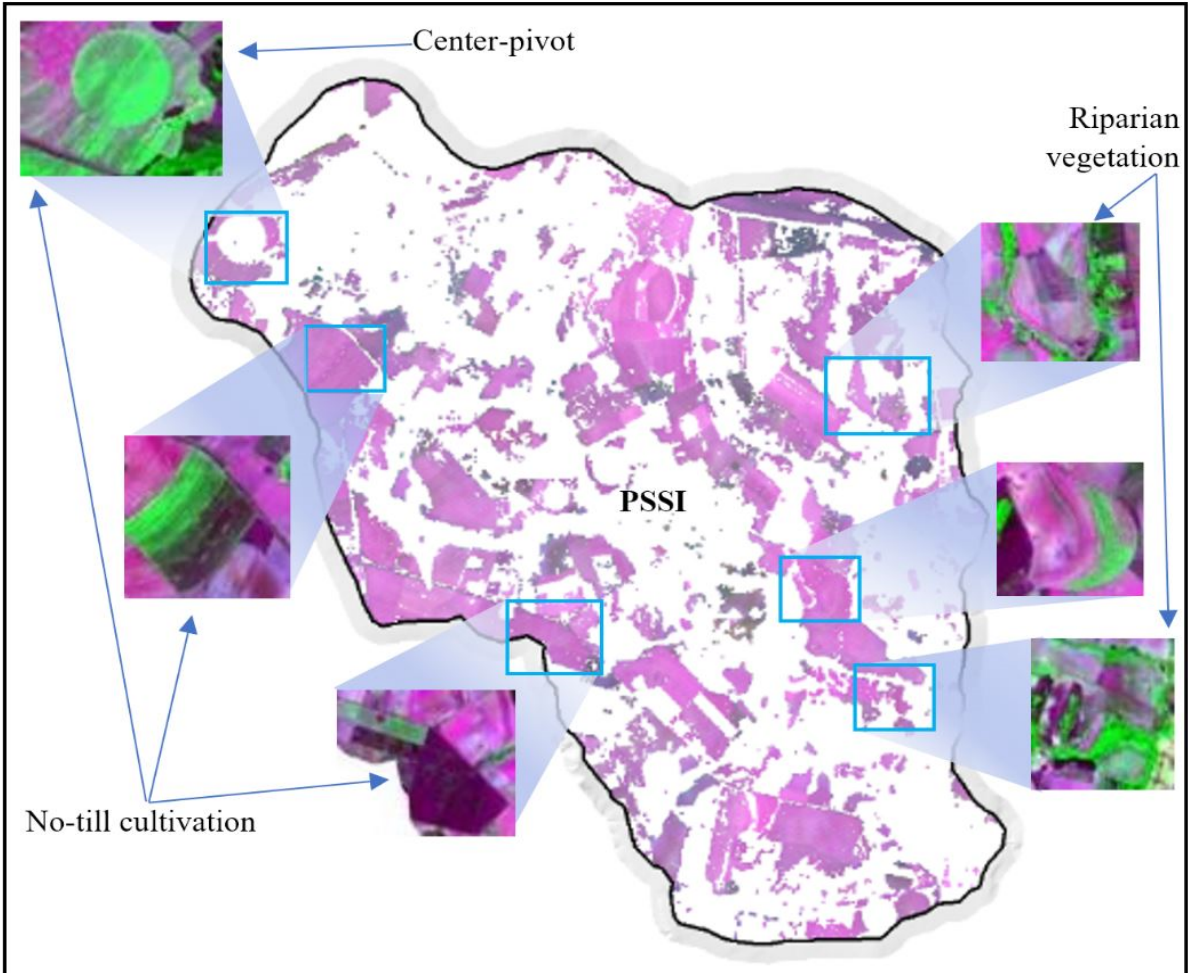
Figure 5. Synthetic Soil Image from the study area outstanding the natural vegetation and agricultural features in the ASTER single images.